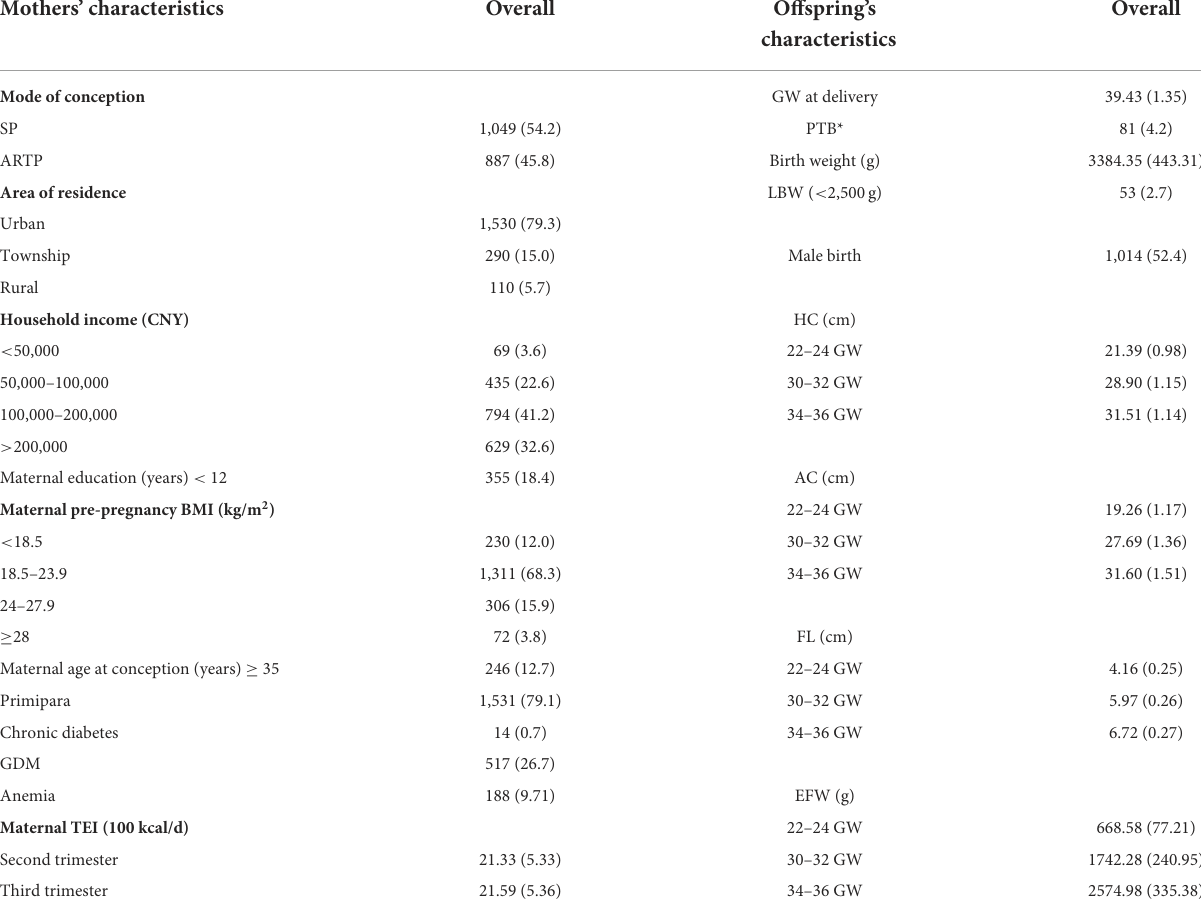
TABLE 1 Characteristics of baseline demographic and lifestyle factors of 1936 mother-infant